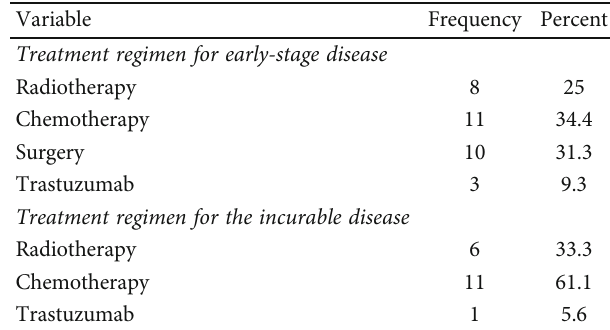
Table 3: Treatment regimen administered to the HER2-positive breast cancer